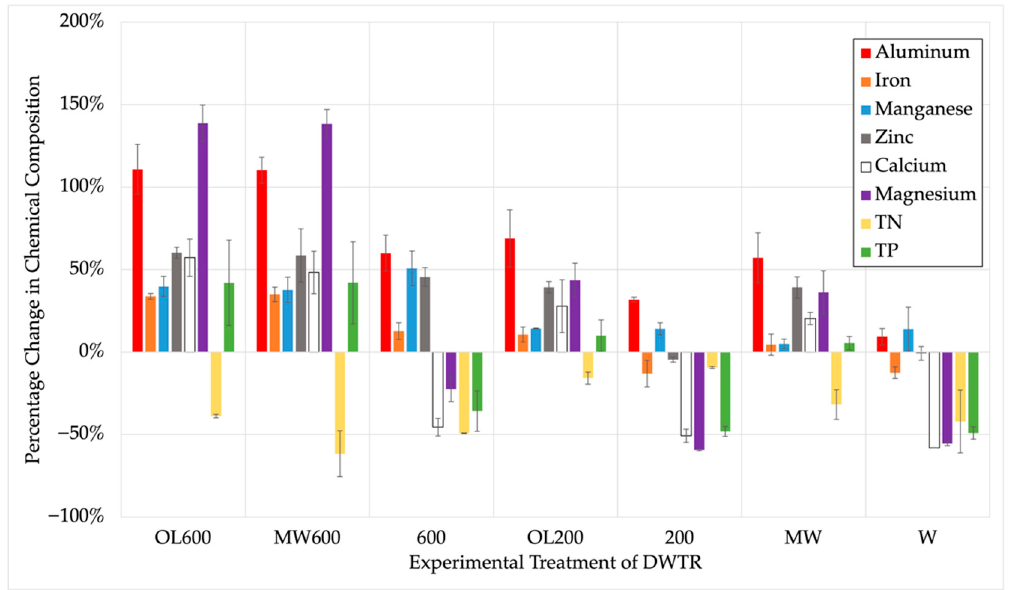
Figure 1. Average relative change (percentage) in concentration of metals and nutrients of two experimentally treated DWTRs (DP, UD) with bars representing the range in the average of the individual DWTR. Descriptions of treatments with abbreviations provided in Table 2.